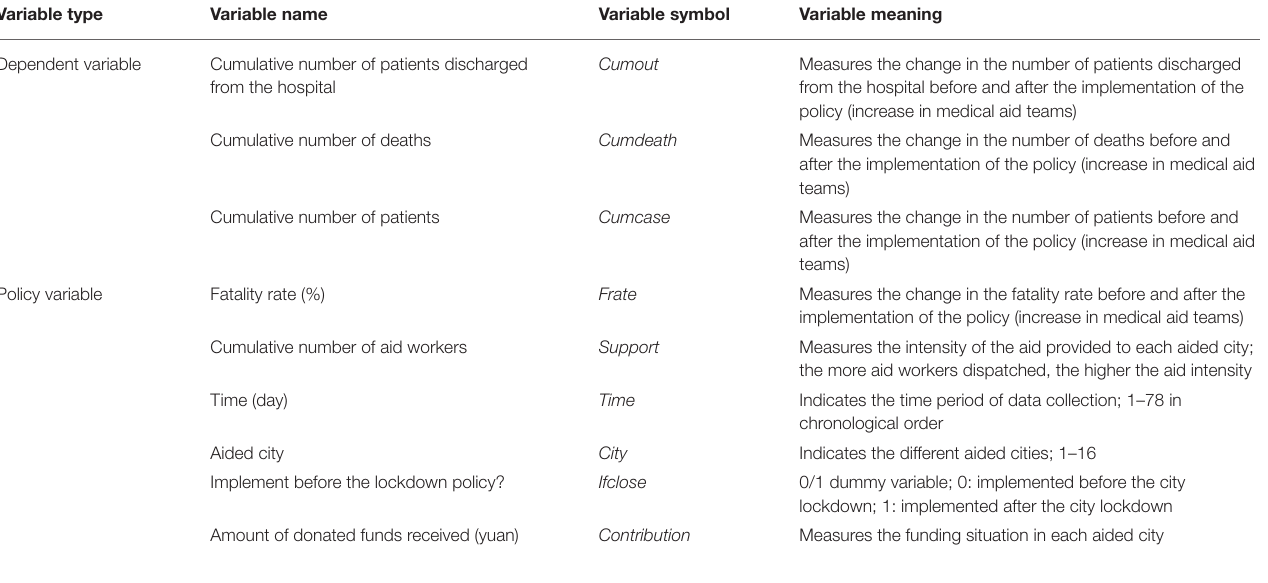
TABLE 2 | Description of the main variables used to evaluate the effect of policy